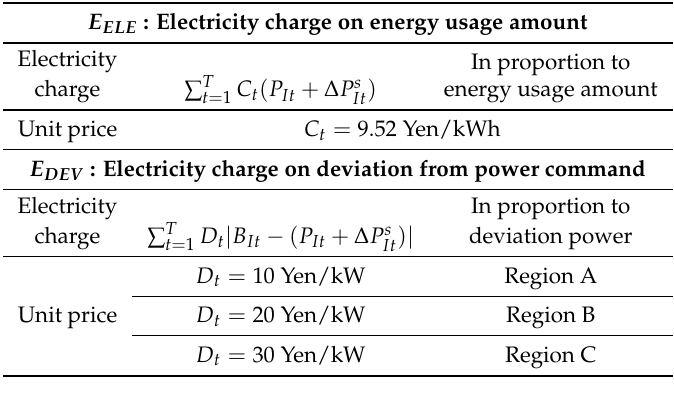
Table 2. Proposed electricity